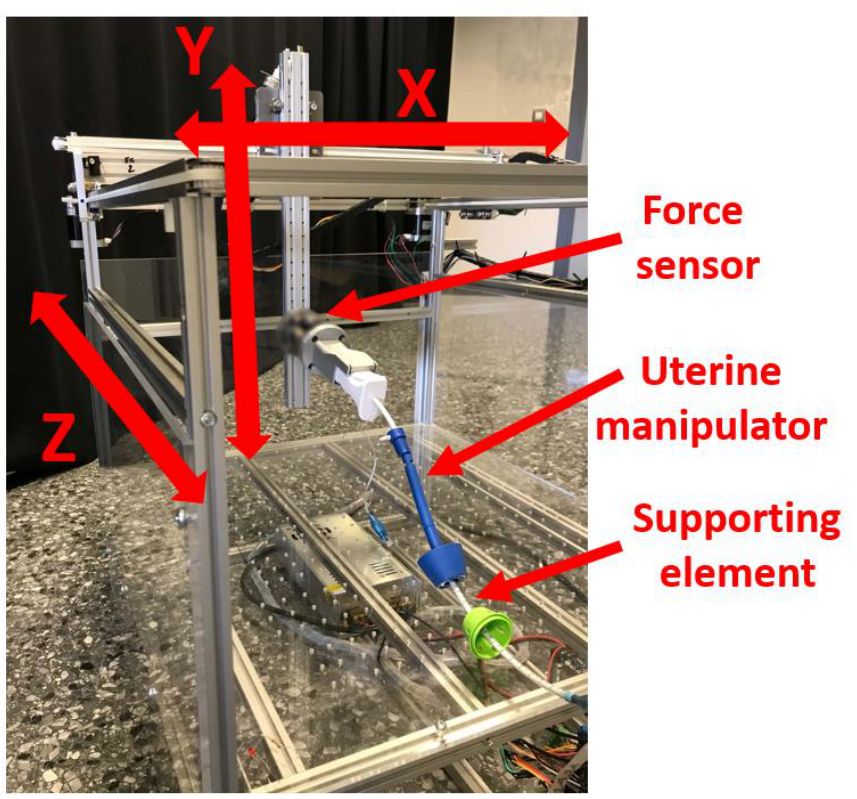
Figure 5. Prototype of the surgical assistance robot (SAR) showing the cartesian robot’s three active coordinates (where q 1 is the axis Z, q 2 is the axis Y and q 3 is the axis X), the force sensor, the support element that is restrict movement at the XY plane and a uterine manipulator.